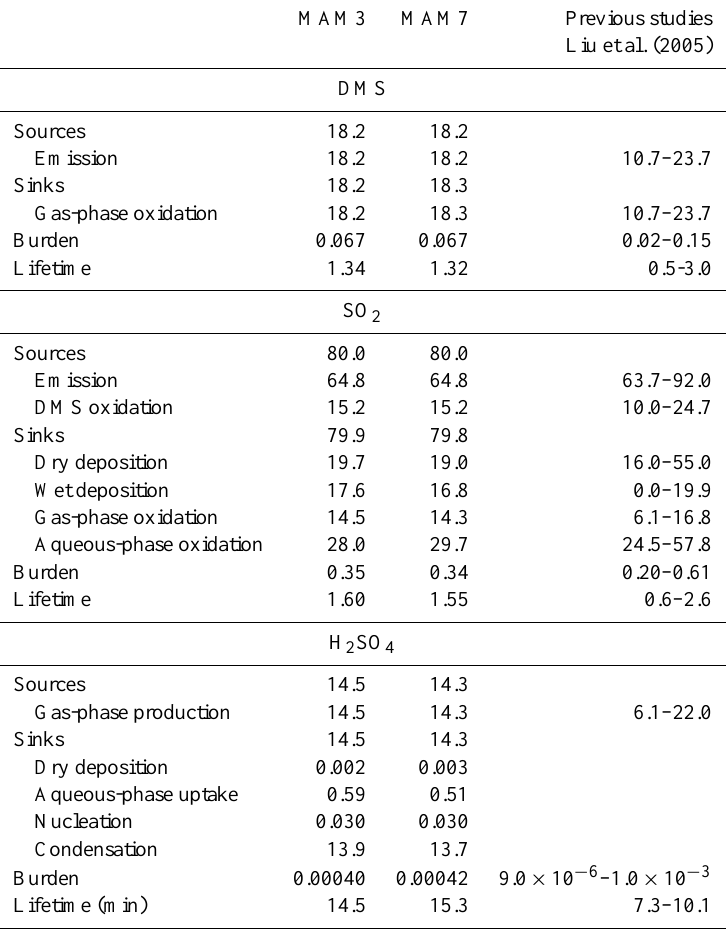
Table 2. Global budgets for DMS, SO 2 , and H 2 SO 4 in MAM3 and MAM7. The range of results from other studies is from Liu et al. (2005) and references